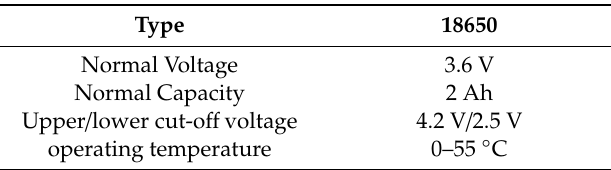
Figure 4. Profiles of battery test loading: ( a ) Highway Driving Schedule (US06); ( b ) Beijing Dynamic Stress Test (BJDST). Table 1. Battery